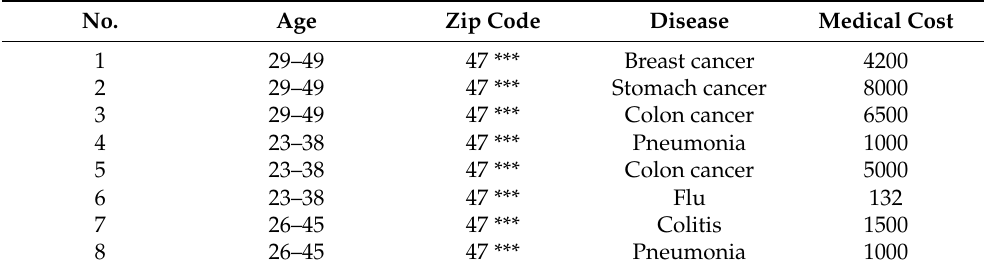
Table 3. A similarity attack version of Table